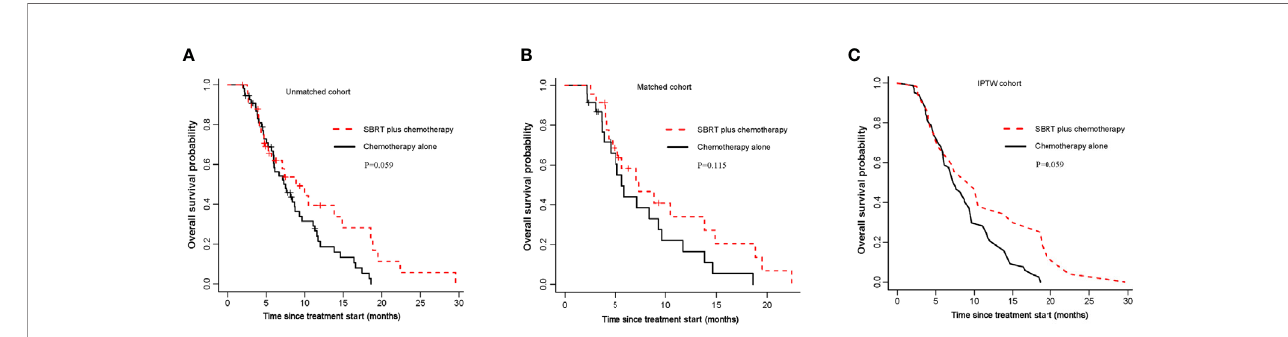
FIGURE 1 | Kaplan-Meier curves for OS. (A) OS of the unmatched cohort; (B) shows OS of the propensity score matched group; (C) shows OS of the inverse probability of treatment weight-adjusted group. SBRT, stereotactic body radiotherapy.